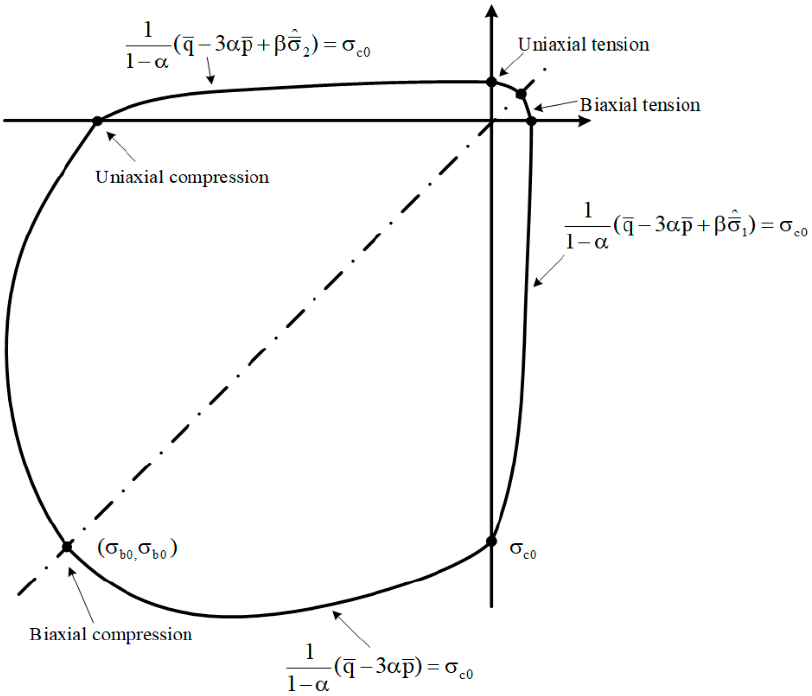
Figure 6. Illustration of the yield surface due to the plane stress, as defined by the concrete damaged plasticity (CDP) model.